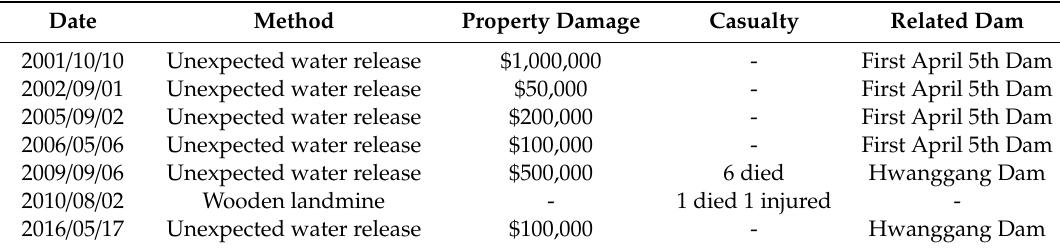
Table 1. Water conflict chronology in the Imjin River from 2001 to 2016